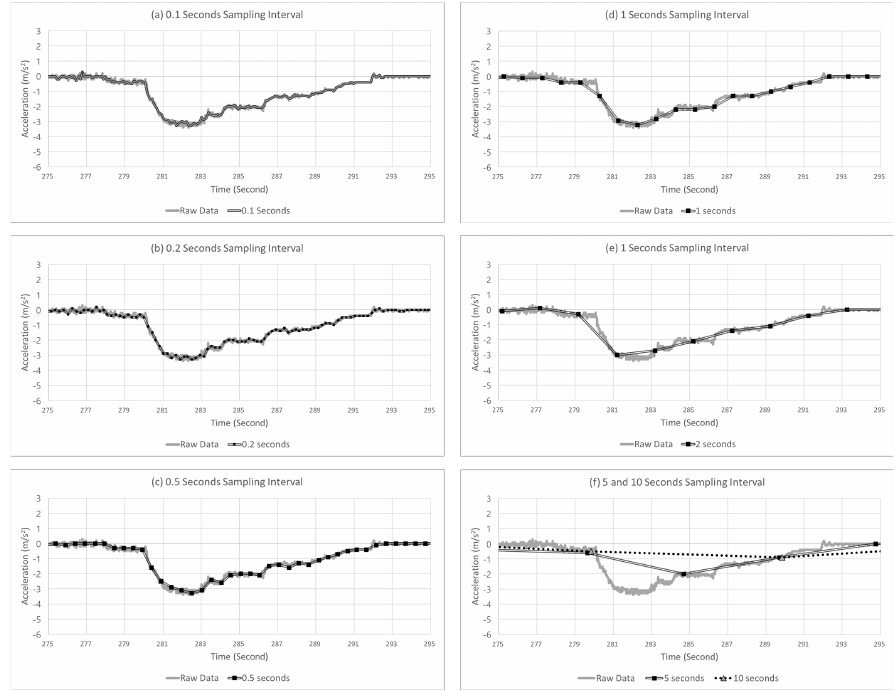
Figure 8. Example case of SD at varying sampling intervals.